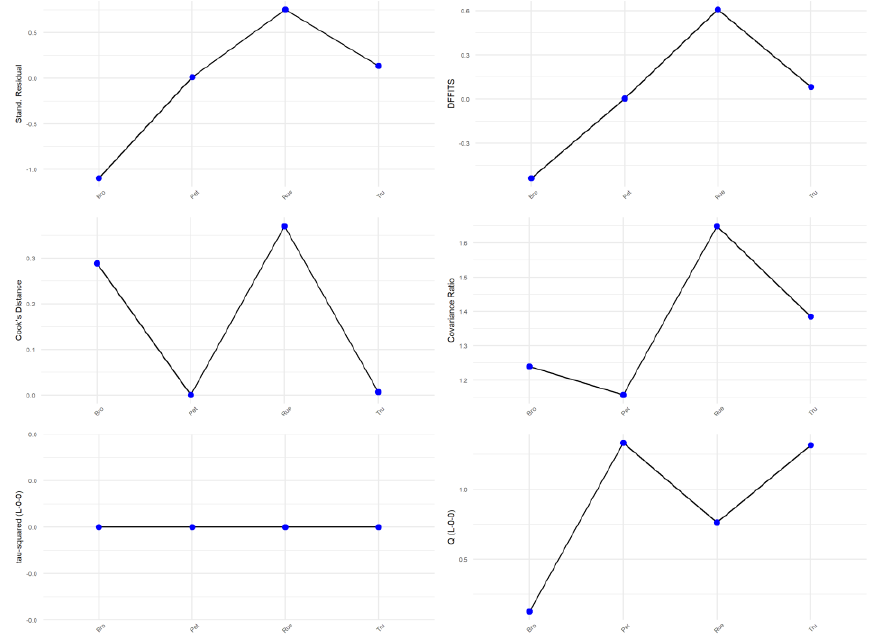
Figure A17. Influence analyses of all the studies.